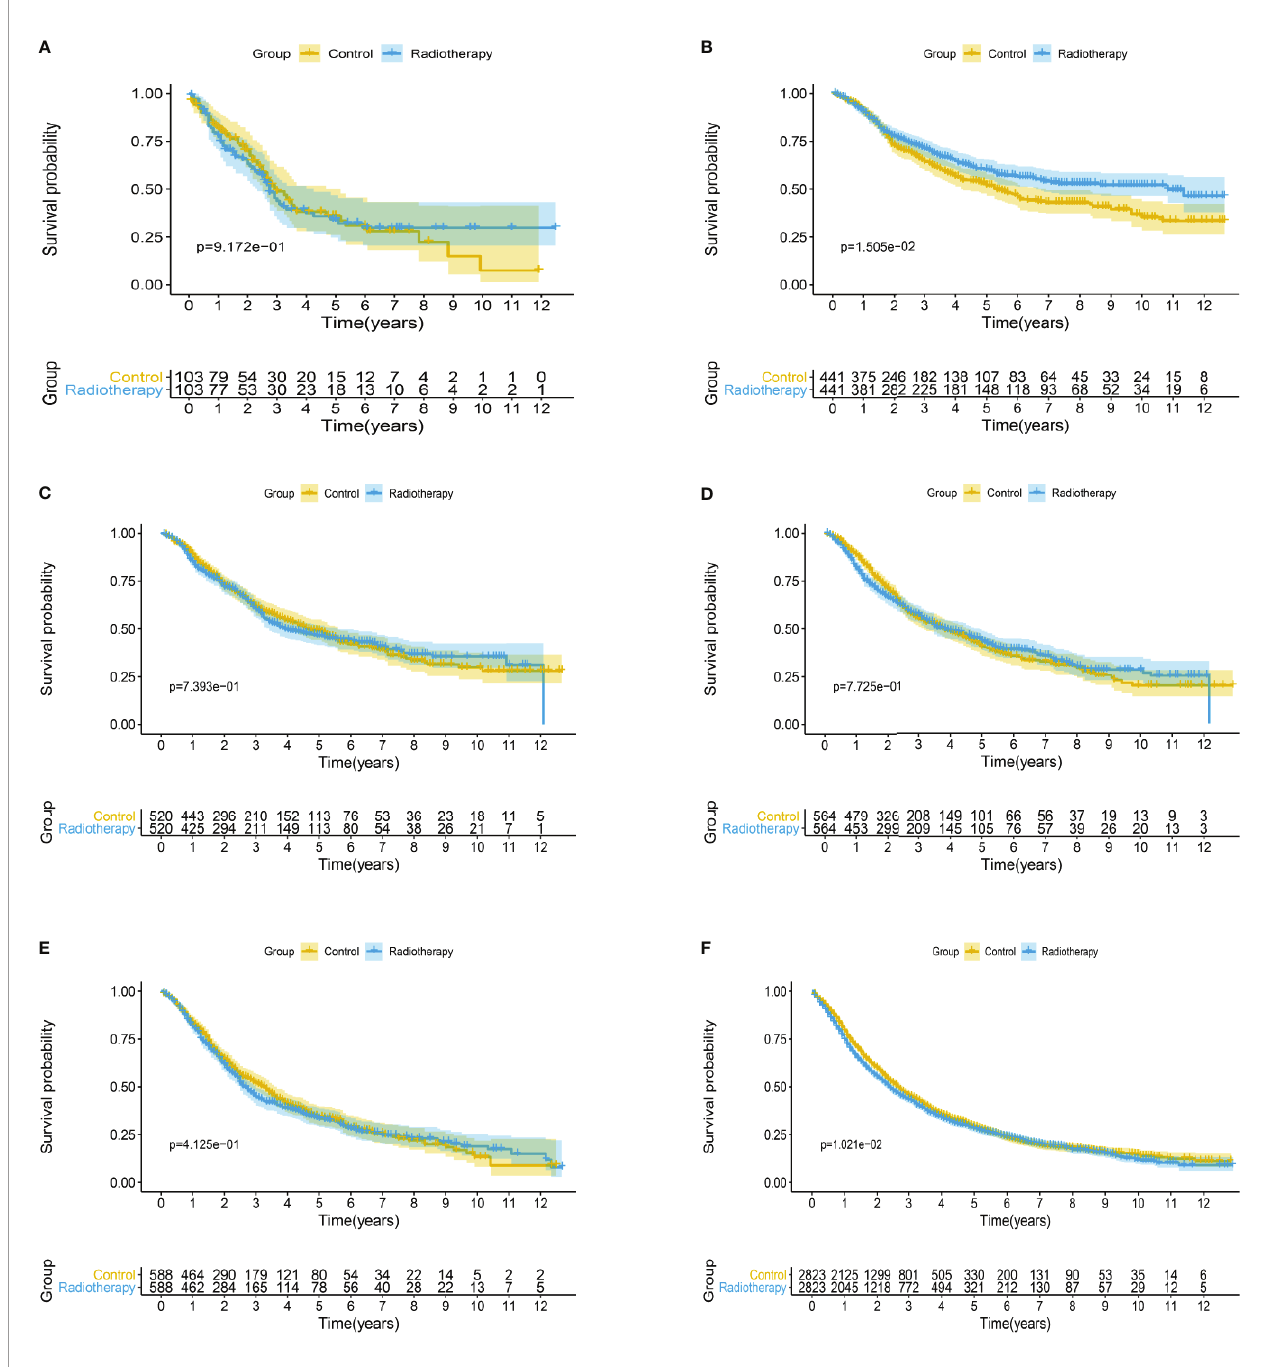
FIGURE 3 | Kaplan-Meier survival analysis of cancer-speci fi c survival in (A) PSA <4 ng/mL, (B) PSA 4.1 – 10 ng/mL, (C) PSA 10.1 – 20 ng/mL, (D) PSA 20.1 – 40 ng/ mL, (E) PSA 40.1 – 80 ng/mL, and (F) PSA >80.1 ng/mL